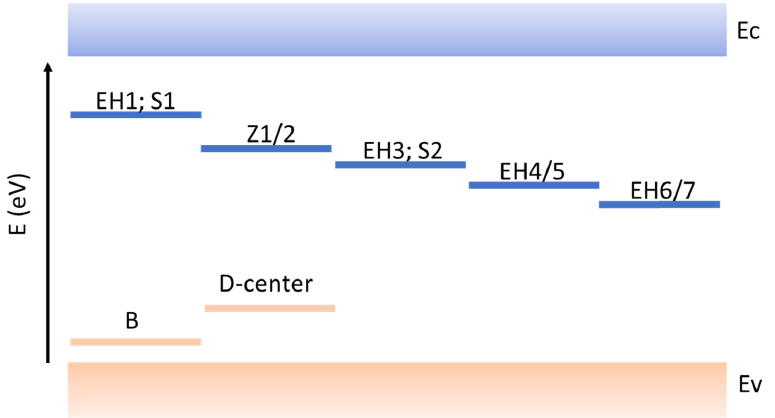
Figure 9. Graphical representation of the energy levels, based on DLTS measurements. Table 1. Details on the majority and minority charge carrier traps in n ‐ type 4H ‐ SiC materials. Trap Label